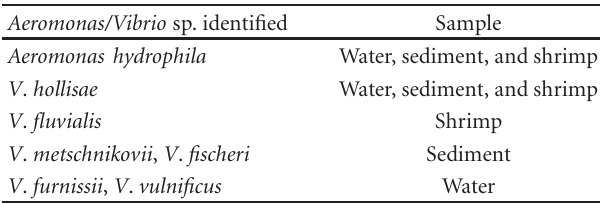
Table 4: Occurrence of Aeromonas hydrophila and Vibrio sp. from water, sediment, and shrimps in feeder canal and shrimp